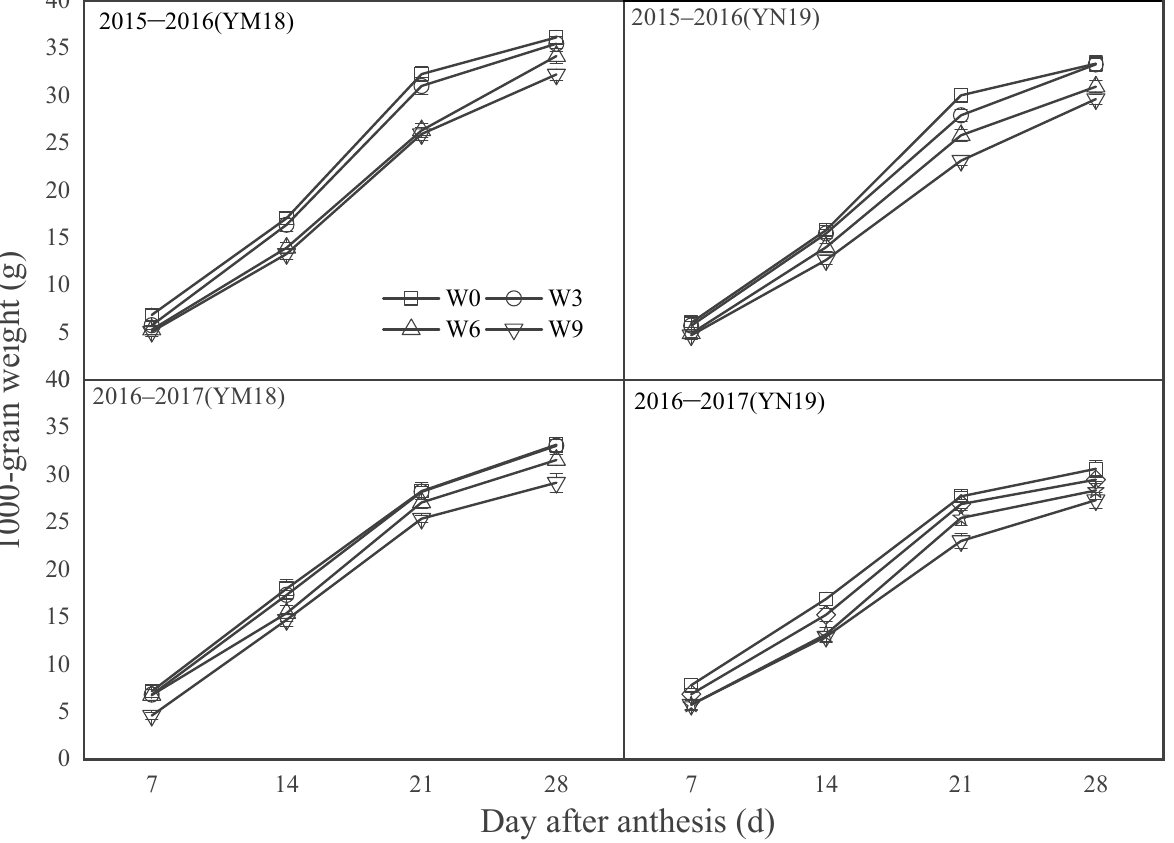
Figure 4. Grain weight of wheat under different treatments. Wheat genotypes YangMai18 (YM18) and YanNong19 (YN19) were subjected to soil waterlogging at anthesis for different durations and data were collected at 0, 7, 14 and 21 days after anthesis. W0 = control, W3 = 3 days of waterlogging, W6 = 6 days of waterlogging, W9 = 9 days of waterlogging. Each data point represents the mean ± SE of three independent replicates.